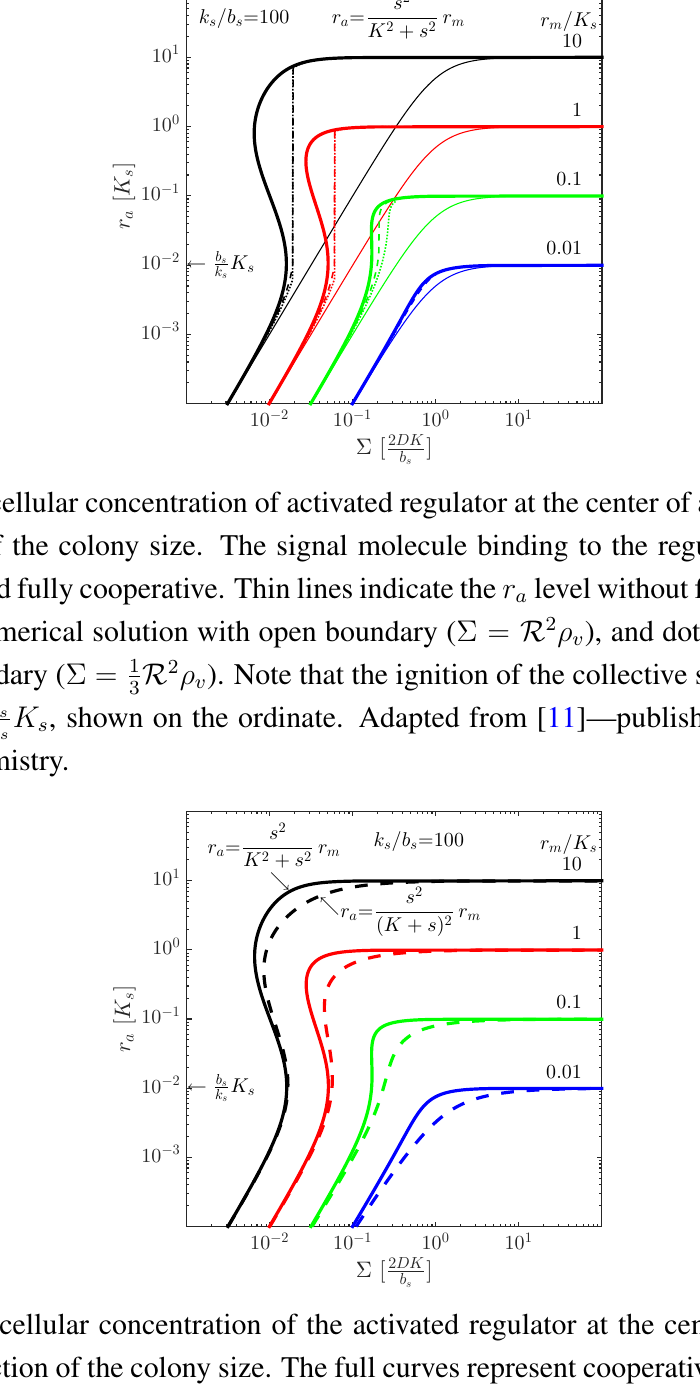
> K , the hysteresis leading m s values m